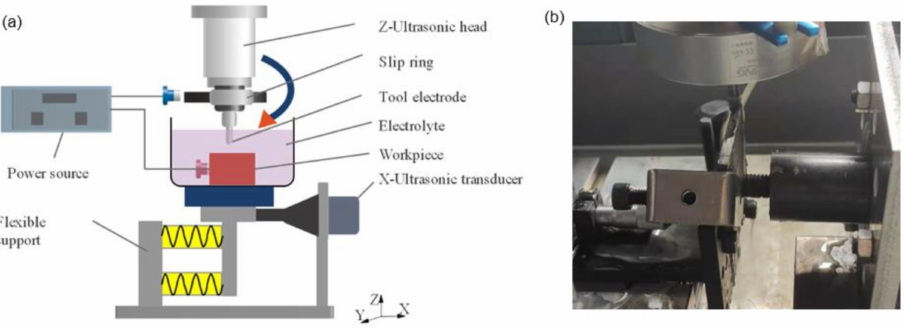
Figure 3. ( a ) Schematic diagram of the experimental setup and ( b ) the actual in-house-built equipment.